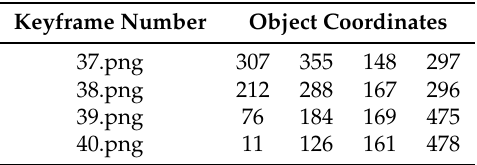
Table 7. The pedestrian position coordinates.